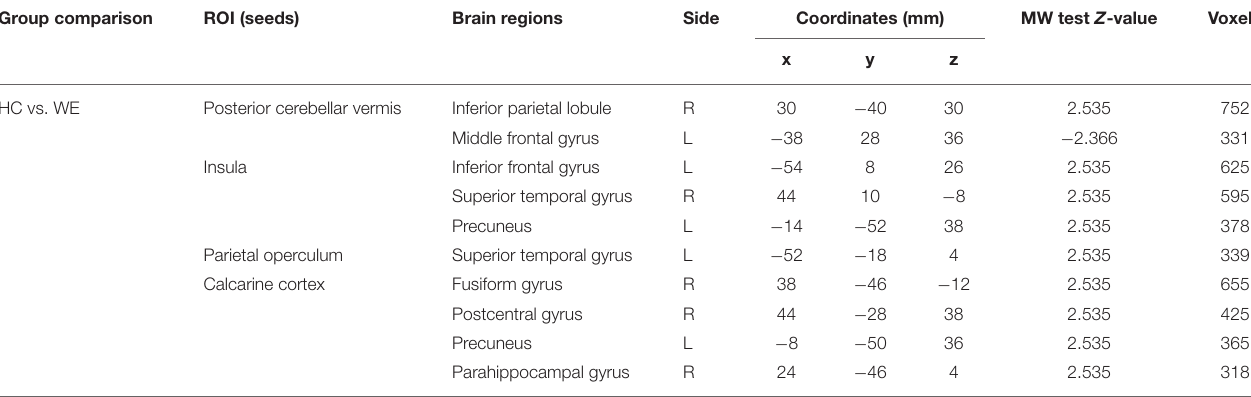
TABLE 2 | Significant clusters in the two-sample t -tests comparing default mode functional connectivity in Wernicke’s encephalopathy patients vs. controls. Group comparison ROI (seeds) Brain regions Side Coordinates (mm) MW test Z -value Voxels